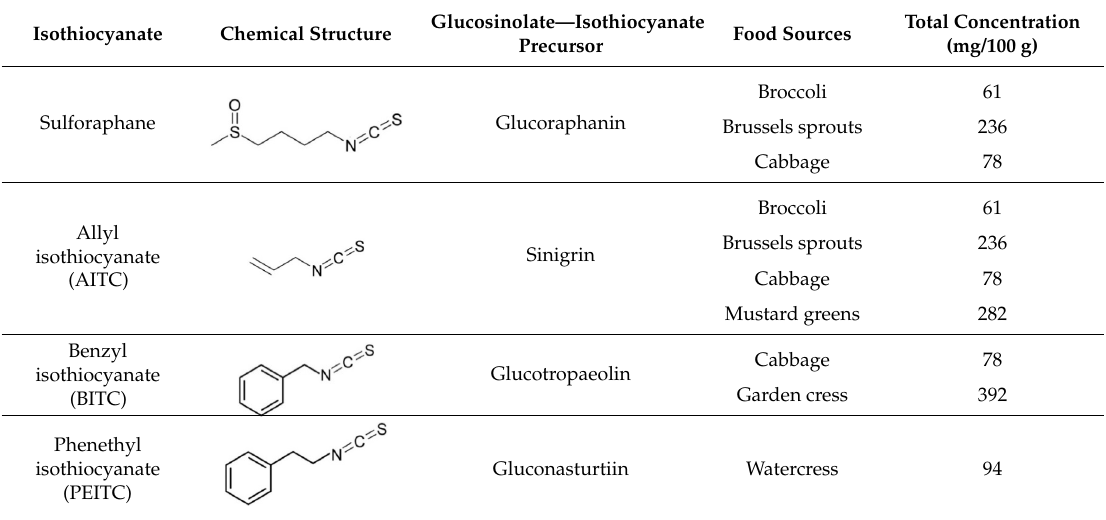
Table 1. Chemical structure of selected isothiocyanates and content of their glucosinolate precursors in raw cruciferous vegetables. Isothiocyanate